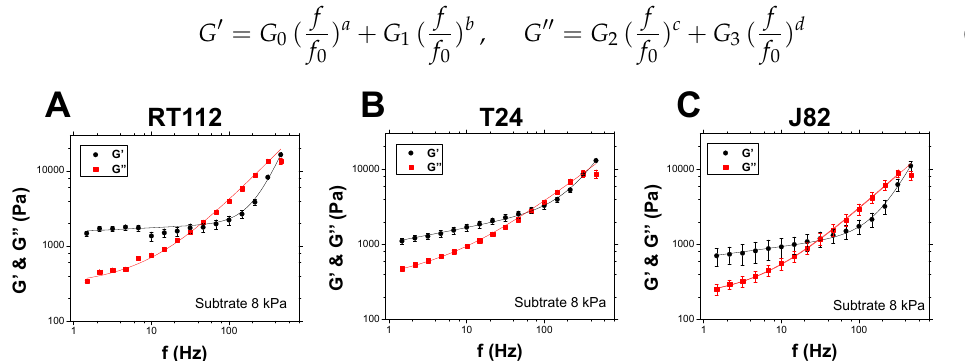
Figure 1. Viscoelastic moduli of RT112, T24, and J82 cells on an 8 kPa substrate. The elastic modulus G (cid:48) (black) and the loss modulus G (cid:48)(cid:48) (red) are shown as a function of frequency f . These measurements were performed above the cell nucleus. The lines correspond to the model in Equation (3), using ( A ) G 0 = 1567 Pa, a = 0.05, G 1 = 0.005 Pa, b = 2.4, G 2 = 321 Pa, c = 0.07, G 3 = 29.4 Pa, d = 1.05, ( B ) G 0 = 1060 Pa, a = 0.20, G 1 = 0.24 Pa, b = 1.7, G 2 = 351 Pa, c = 0.08, G 3 = 84 Pa, d = 0.8 and ( C ) G 0 = 682 Pa, a = 0.14, G 1 = 0.04 Pa, b = 2, G 2 = 205 Pa, c = 0.01, G 3 = 40 Pa, d = 0.92. N = 5; error bars represent the mean ± the standard error of the mean